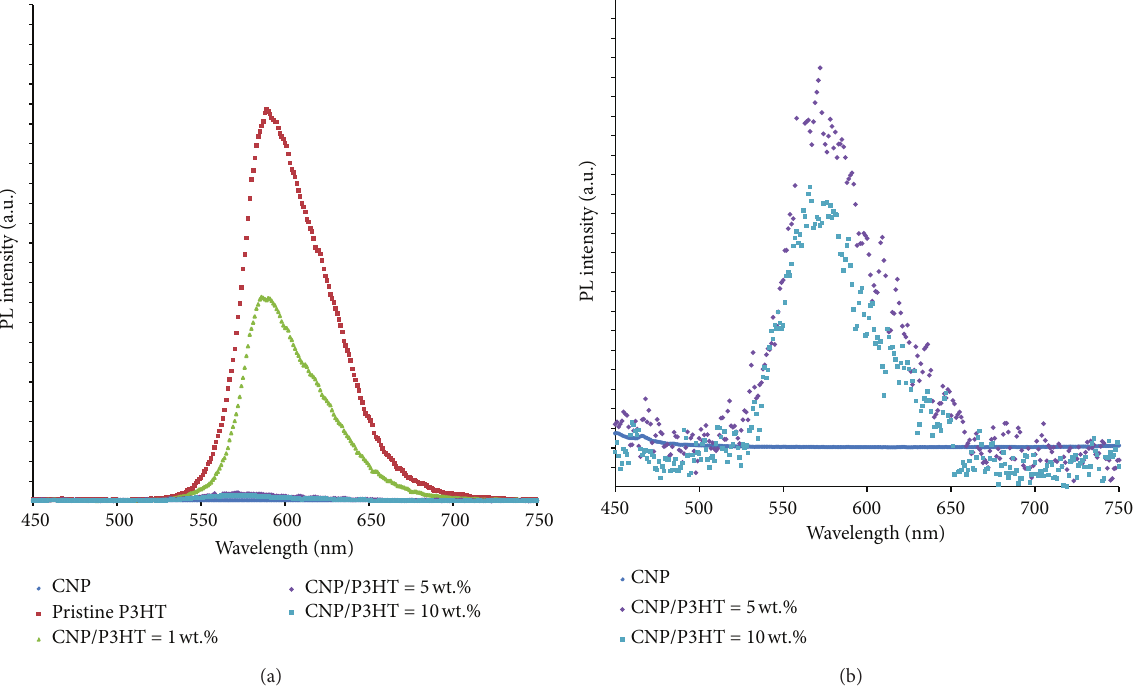
Figure 8: Photoluminescence spectra of CNPs, pristine P3HT, CNP/P3HT = 1wt.%, 5 wt.%, and 10 wt.%.